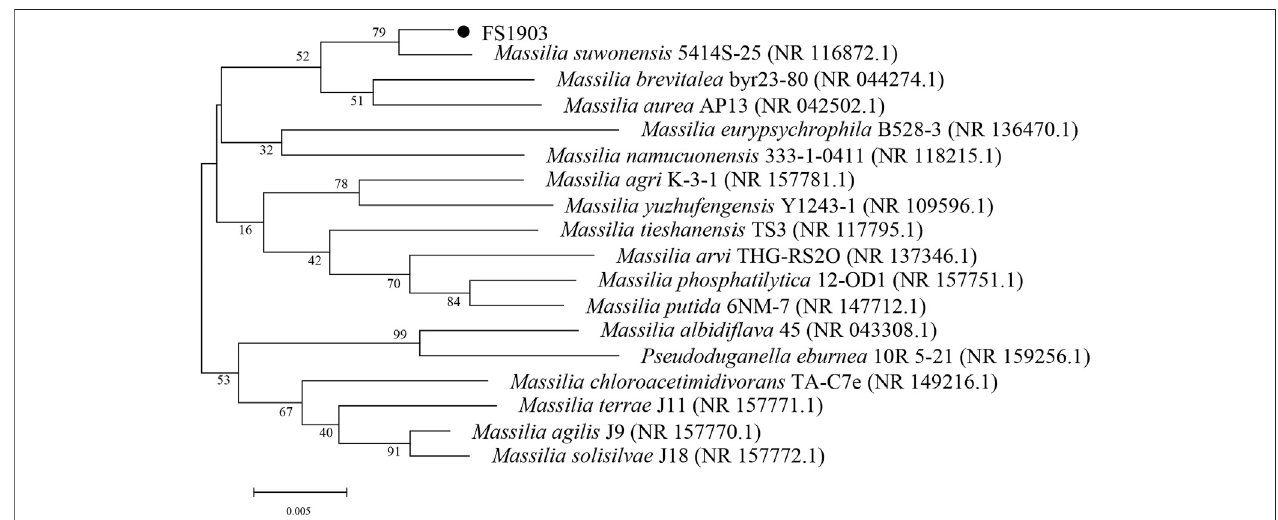
FIGURE 1 | Neighbor-joining phylogenetic tree of strain FS1903 based on the 16S rRNA gene.